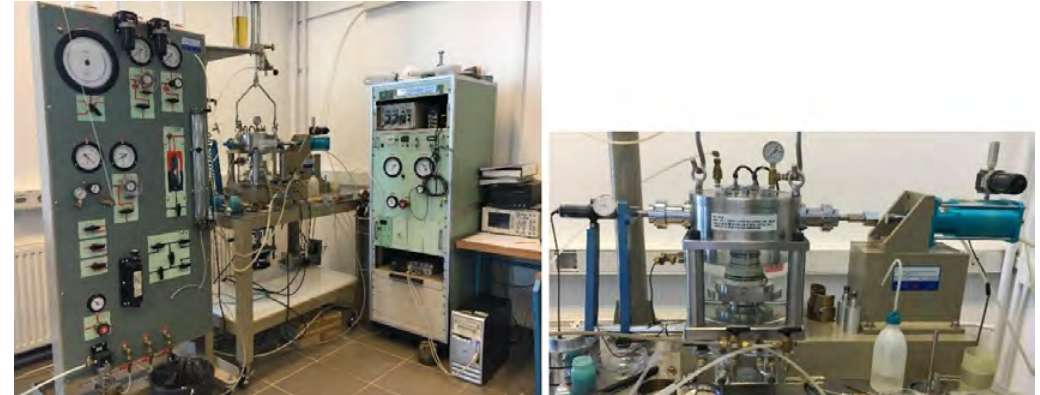
Figure 6. The Seiken cyclic simple shear apparatus, used for the laboratory tests (left) and the cell (right).